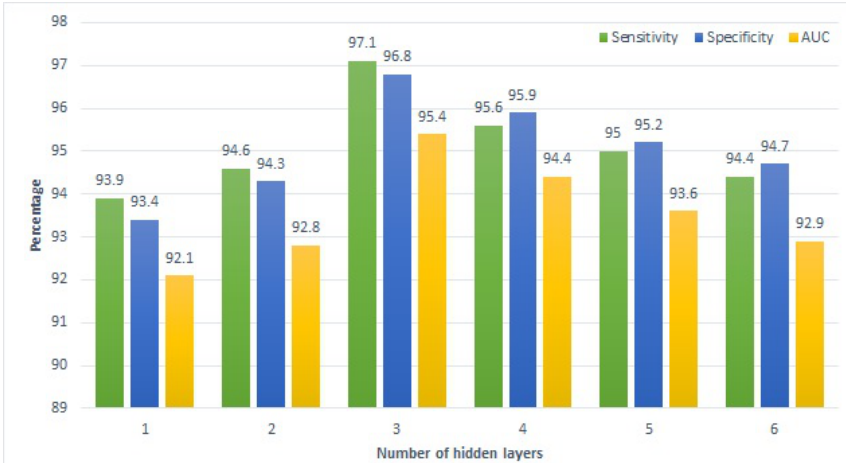
Figure 7. Performance of the proposed approach on combined